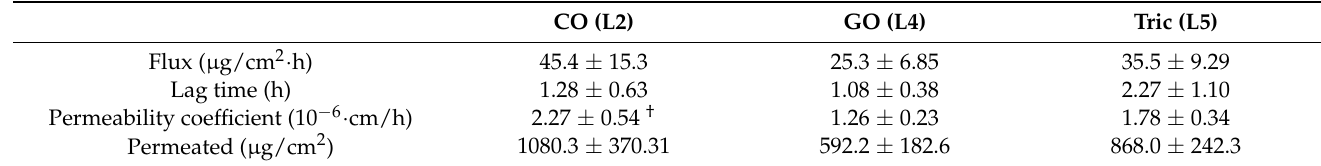
Table 3. Ex vivo permeation parameters of Vit C after topical administration of LOSs with different neutral oils through porcine